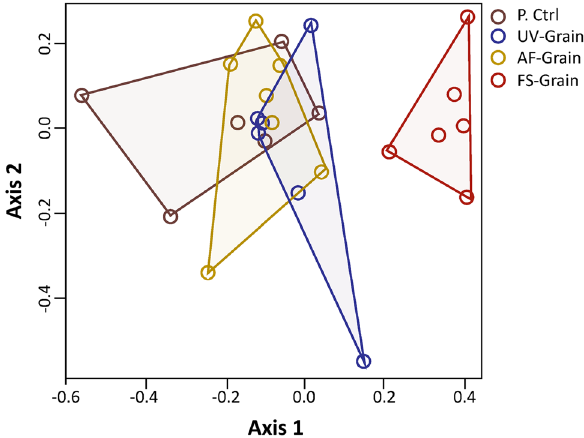
Figure 6. Non-metric multi-dimensional scaling ordination plot based on pairwise Bray–Curtis similarity index calculated between each combination of volatile emissions (ng h −1 g −1 grain) by samples after headspace collection for 3 h from 20 g of grain that was UV sanitized for 10 min (blue circles), inoculated with A. flavus (yellow circles), inoculated with Fusarium spp (red circles), or uninoculated (brown circles). There were n = 7 replicates per semiochemical treatment. Polygons represent convex hulls drawn between samples and are color coded similarly to treatments. There were a total of n = 1000 permutations, and stress was < 0.10, enabling adequate interpretation. UV-grain, UV-sanitized grain; P. Ctrl, uninoculated grain; FS-grain, F. verticillioides - inoculated grain; AF-grain, A. flavus -inoculated grain.